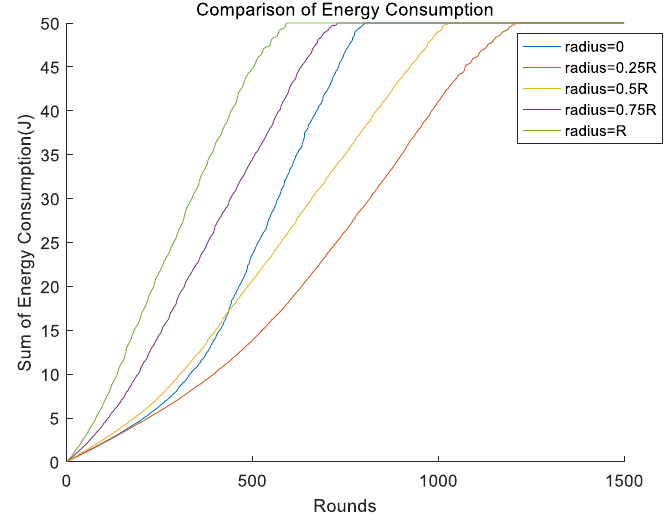
Figure 10. Energy consumption of different radius of single mobile sink.